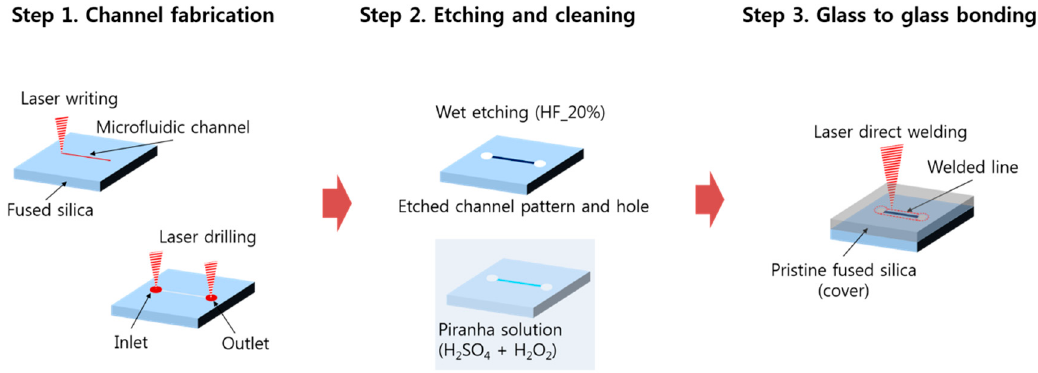
Figure 1. Illustration of the rapid and mask-less glass microfluidic channel device fabrication procedure by using a femtosecond laser. HF—hydrofluoric acid.